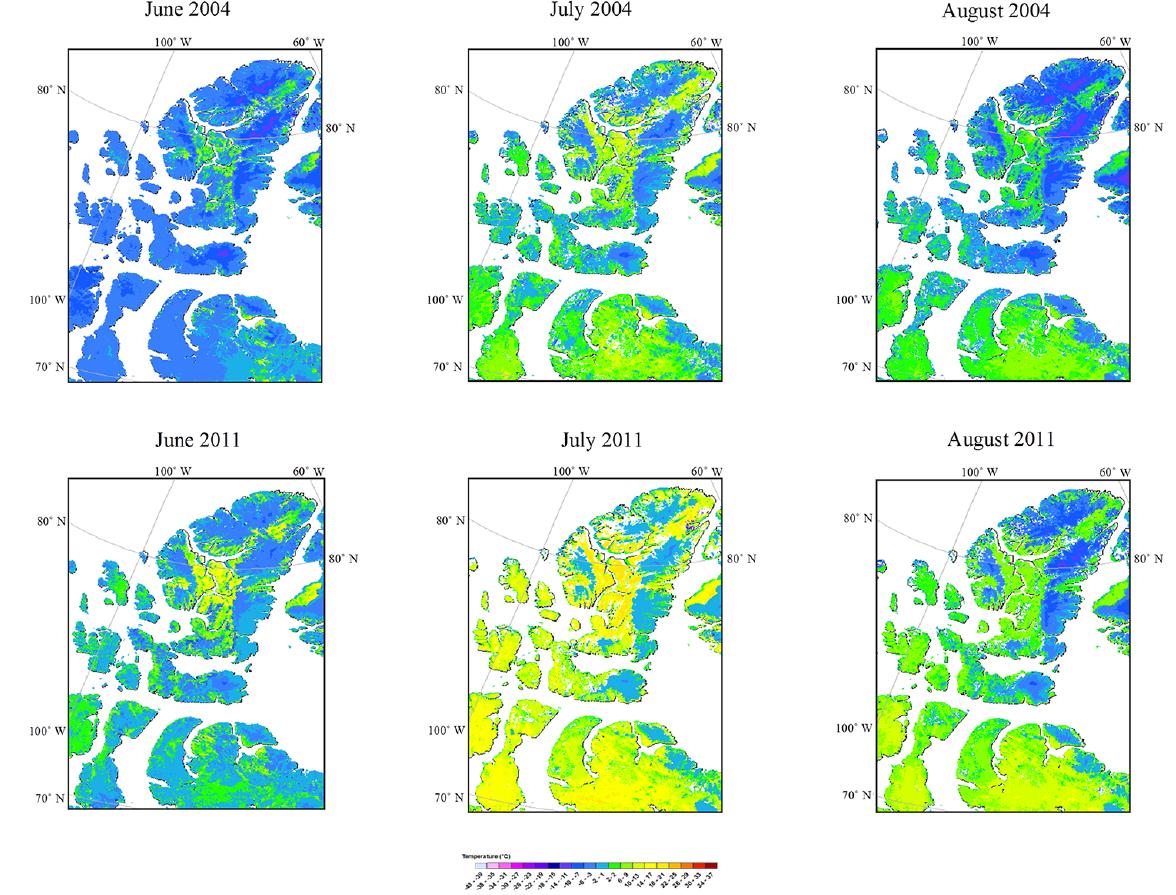
Figure 11. Mean land surface temperature derived from MODIS Aqua/Terra over the central/eastern CAA during the months of June, July, and August of 2004 (colder year) and 2011 (warmer